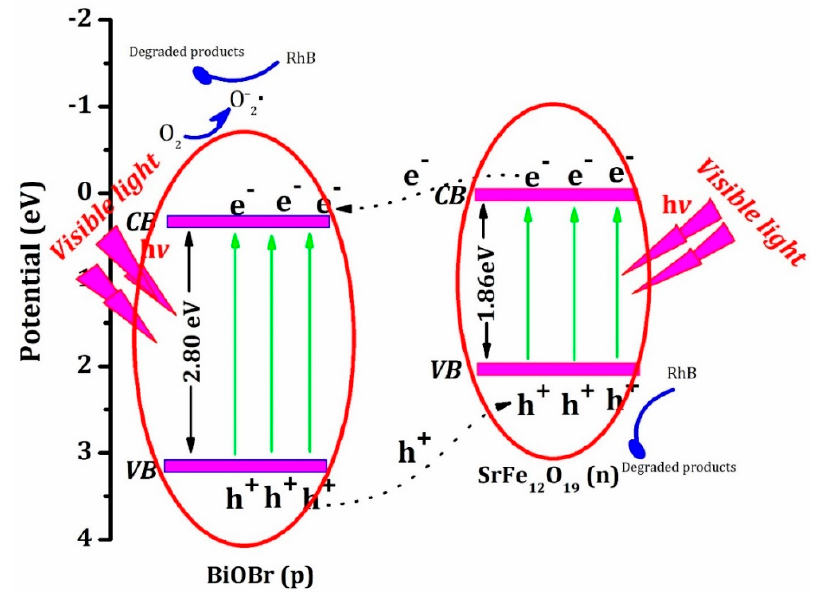
Figure 11. Photocatalytic mechanism scheme of BOB-SFO-5 under visible light irradiation.